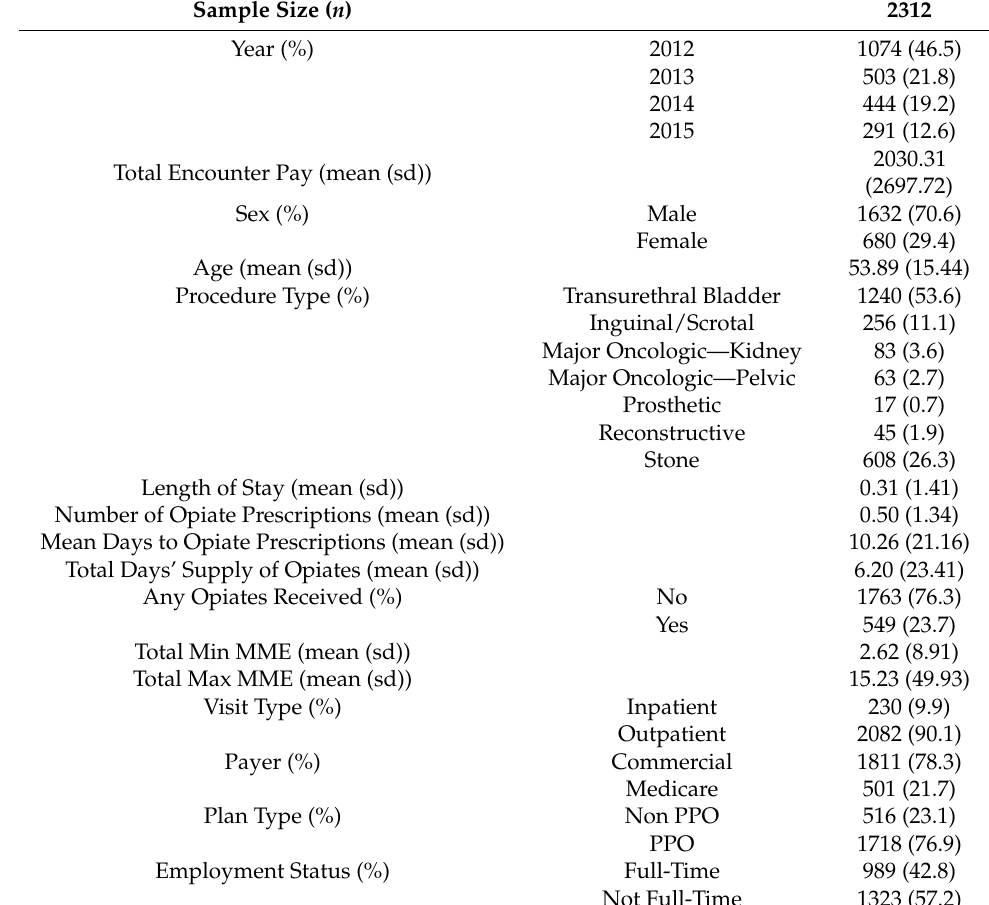
Table 1. Baseline characteristics of the total population of encounters